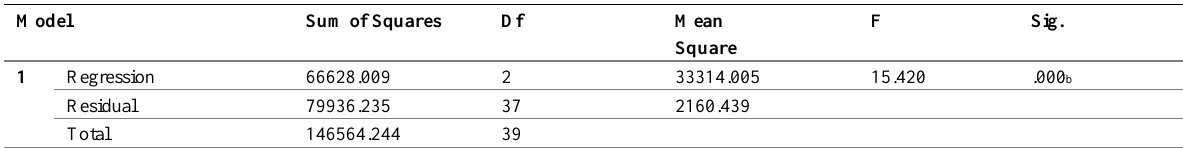
Table 7: The F Test